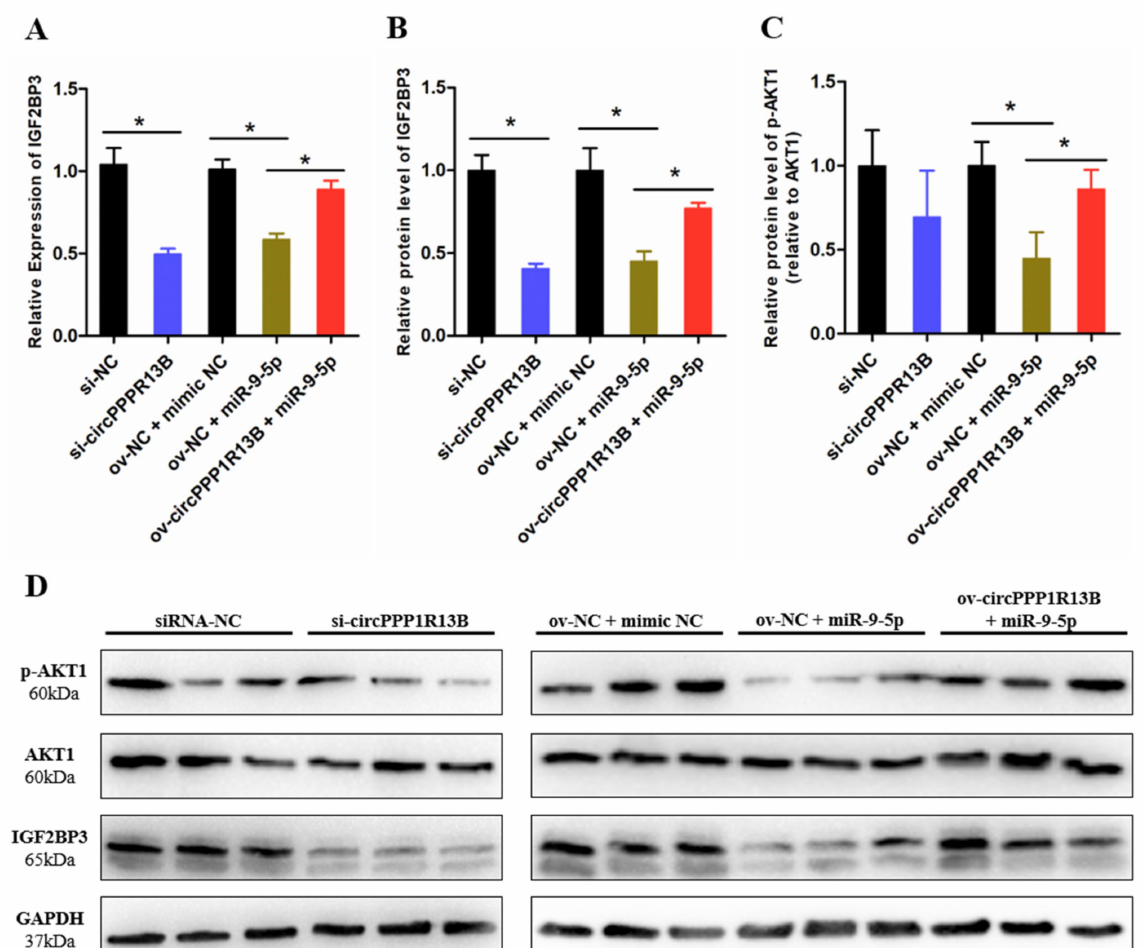
Figure 3. CircPPP1R13B regulates IGF2BP3 mediated IGF/PI3K/AKT signaling via targeting miR-9-5p. ( A ) Relative mRNA expression of IGF2BP3 following circPPP1R13B knockdown or co-overexpression with miR-9-5p. ( B ) Relative protein level of IGF2BP3 following circPPP1R13B knockdown or co-overexpression with miR-9-5p. ( C ) Relative protein phosphorylation level of AKT1 following circPPP1R13B knockdown or co-overexpression with miR-9-5p. ( D ) Protein levels of IGF2BP3, p -AKT1, AKT1, and GAPDH were determined by western blot analysis. Asterisk indicate significant differences from the respective control (* p <